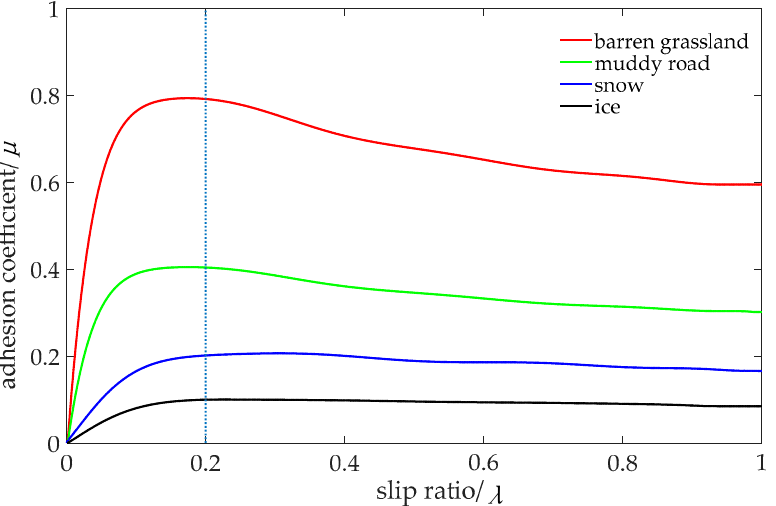
Figure 3. Schematic diagram of four typical track-ground conditions, where the adhesion coefficient can be indicated as µ and slip ration can be indicated as λ .